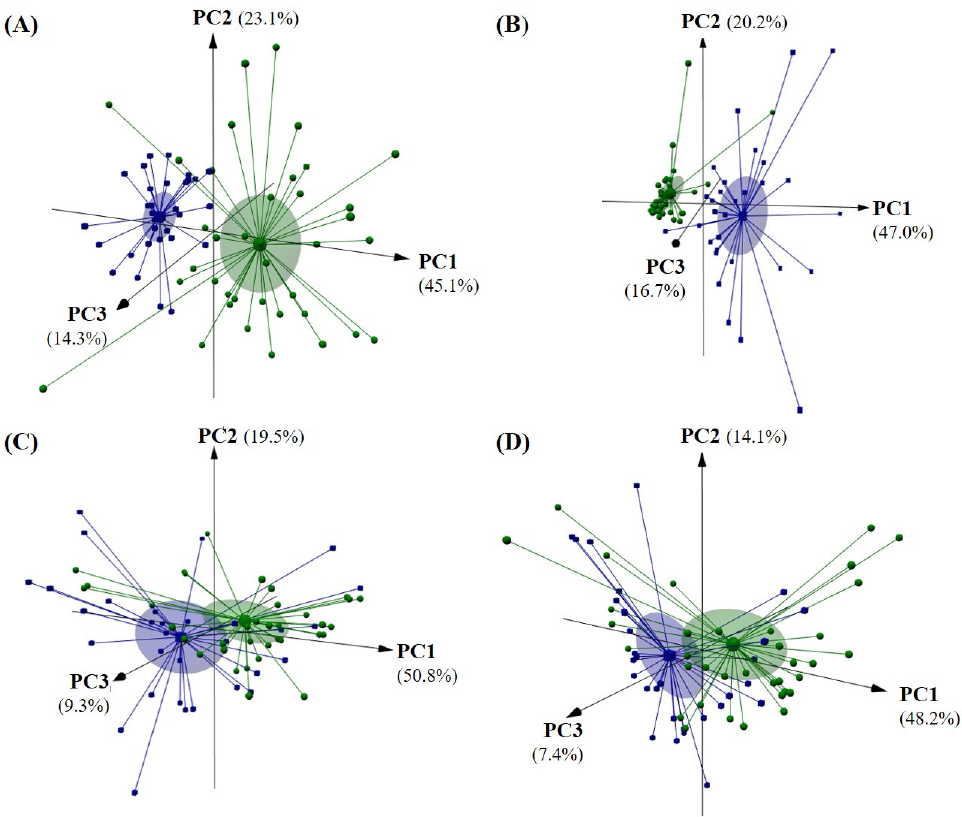
Figure 3. Unsupervised pattern recognition of olive oils by geographical origin (Côa Valley: ● , and, Douro Valley: ■ ) based on the principal component analysis (3D plot of the three first PCs) based on: ( A ) physicochemical quality data (FA, PV, K 232 and K 268 ), oxidative stability (OS), and antioxidant reducing capacity (TPC and DPPH); ( B ) contents of the volatiles belonging to eight chemical families (alcohols, aldehydes, alkanes, alkenes, esters, ethers, ketones, and terpenes); ( C ) intensities of the perceived olfactory sensations (fruity greenly or ripely, apple, banana, cabbage, dry fruits, tomato, dry herbs, fresh herbs, and tomato leaves); and ( D ) intensities of the perceived gustatory sensations (fruity greenly or ripely, bitter, sweet, pungent, apple, banana, cabbage, dry fruits, plum, tomato, dry herbs, fresh herbs, olive leaves, and tomato leaves).